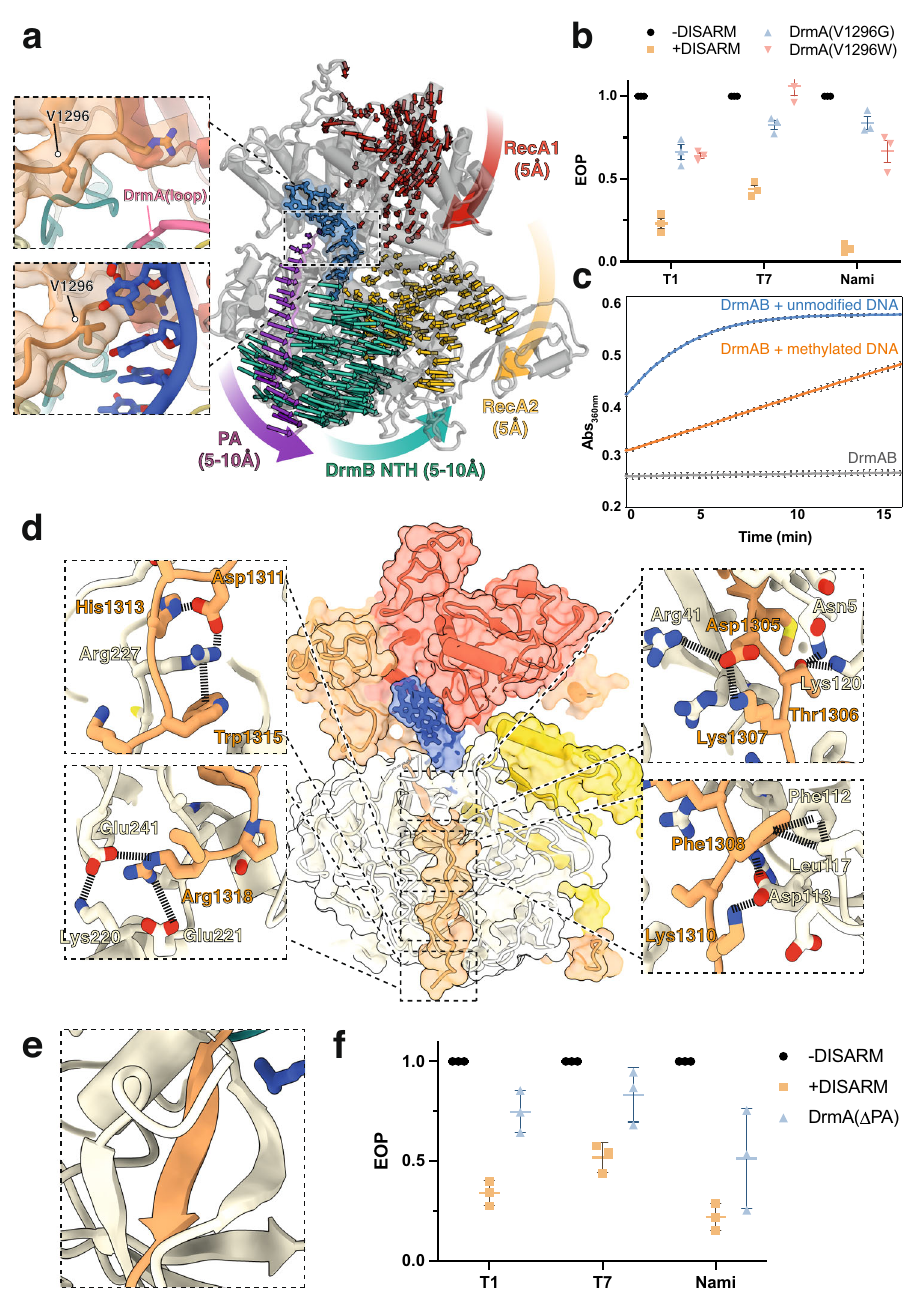
Fig. 4 Binding of unmethylated ssDNA activates DrmAB through large conformational rearrangements. a DrmA C-terminal pivot arm (PA) interface with substrate DNA. Left: close-up views of DrmAB map and model lacking DNA (top) and DrmAB:DNA map and model (bottom). In the DNA-bound map, a direct interaction between a DNA base and Val1296 is present (black arrow). In the DrmAB map lacking DNA, the DrmA autoinhibition loop is present (pink arrow). Right: Motion vectors showing conformational changes of DrmAB upon DNA binding. DrmB N-terminal half (DrmB NTH, cyan) does not make direct contacts with DNA but undergoes a large conformational change upon DNA binding, mediated by the PA of DrmA (magenta). Distances of conformational changes are shown parenthetically. Motion vectors for shifts smaller than 3 Å are omitted. b EOP assay to determine the effects of V1296G or V1296W mutations to DISARM activity. Points correspond to three biological replicates, with mean and standard deviation shown. Source Data are provided as a Source Data fi le. c ATPase assay measuring the rate of ATP hydrolysis by DrmAB, as monitored by increase in absorbance at 360 nm. In the absence of DNA, no ATPase activity is monitored. In the presence of DNA stem loop lacking modi fi cation (blue), ATPase activity is observed. This is severely reduced for DNA containing three separate 5-methyl cytosine bases (orange). DNA sequences are listed in Supplementary Table 2. Experiments were performed in triplicate, and the mean and standard deviation of the mean are depicted. Source Data are provided as a Source Data fi le. d Close-up views of DrmA(CTR):DrmB interactions. e DrmA C-terminus forms a β -sheet in trans with DrmB. f Effect of truncation of DrmA PA on DISARM anti-phage activity. Points correspond to three biological replicates, with mean and standard deviation shown. Source Data are provided as a Source Data fi